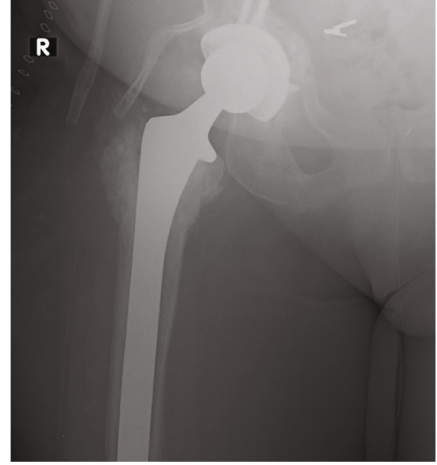
Figure 10: XR right hip. Long porous coated